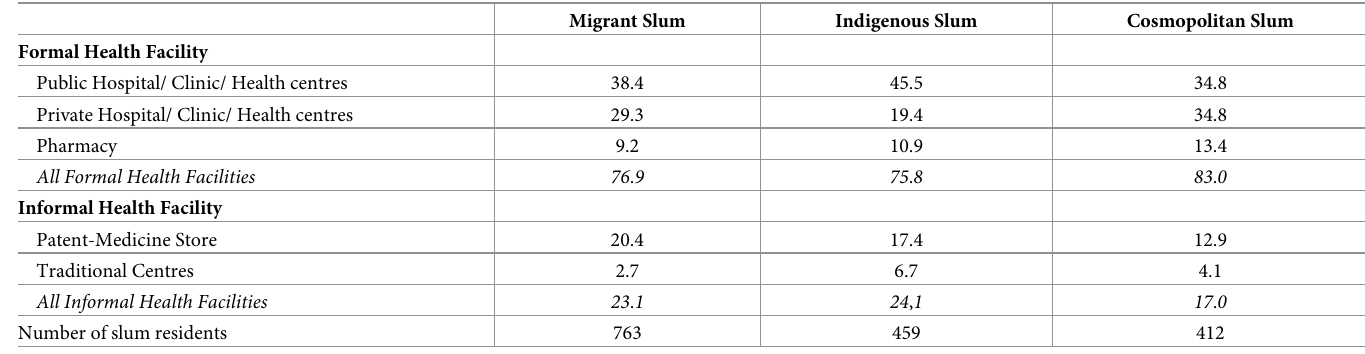
Table 2. Percentage distribution of type of healthcare facility used by slum residents on their most recent visit to health services in three urban slums in Nigeria.